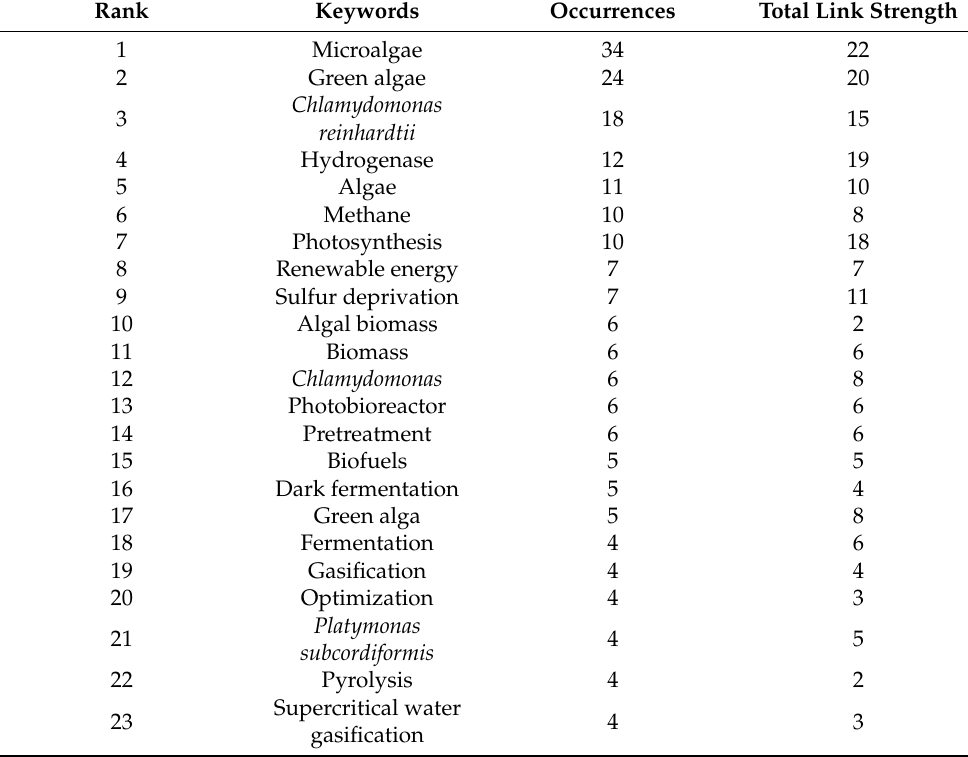
Table 1. The Total Link Strength of the 23 keywords that have at least four minimum occurrences.